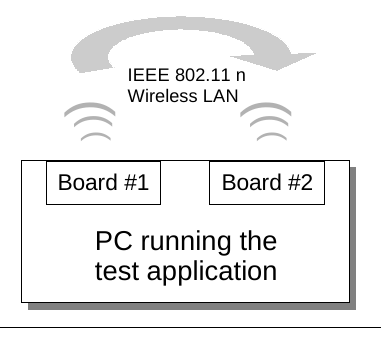
Figure 1. A Sketch of the Experimental